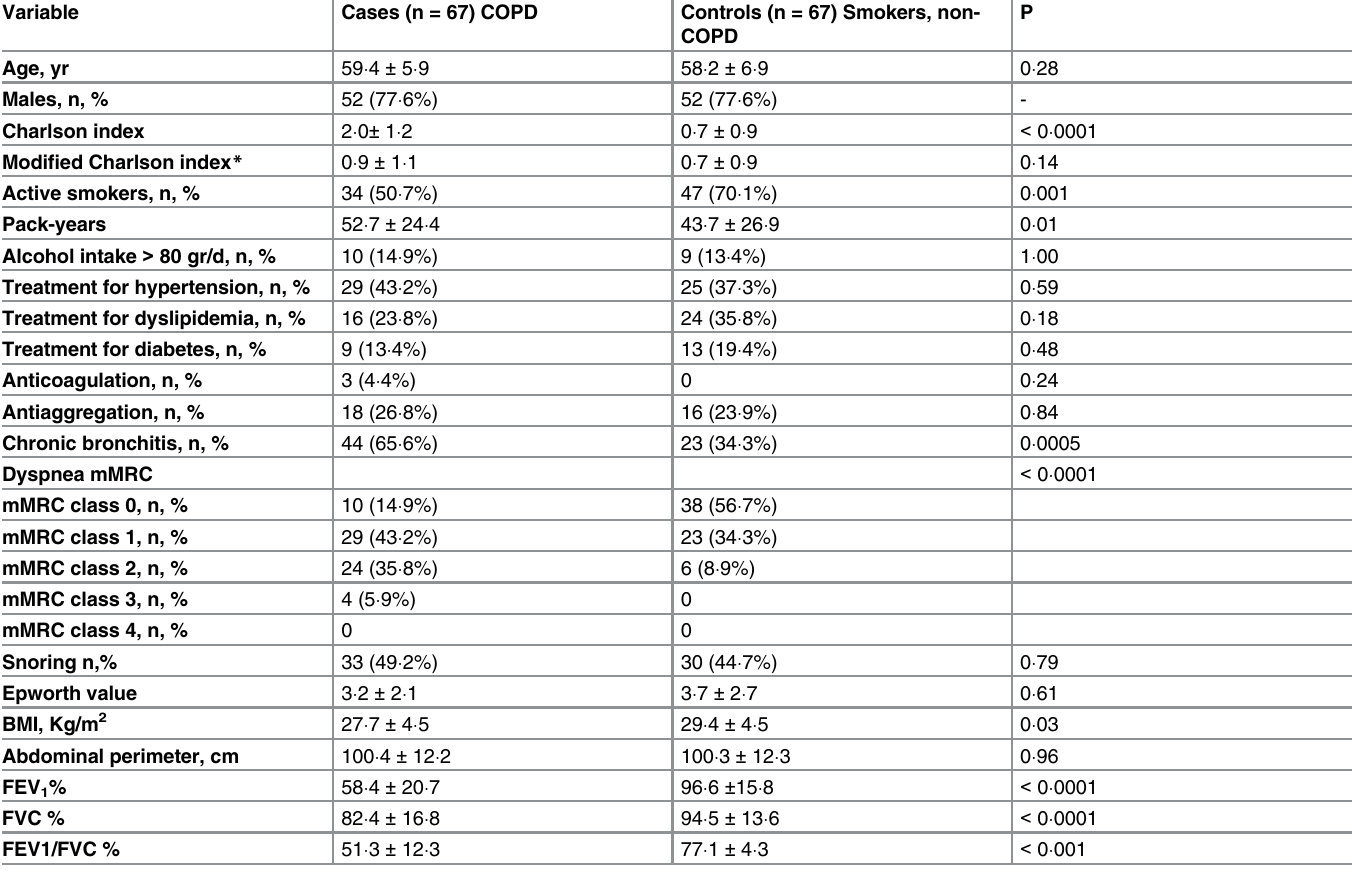
Table 1. Main characteristics of the